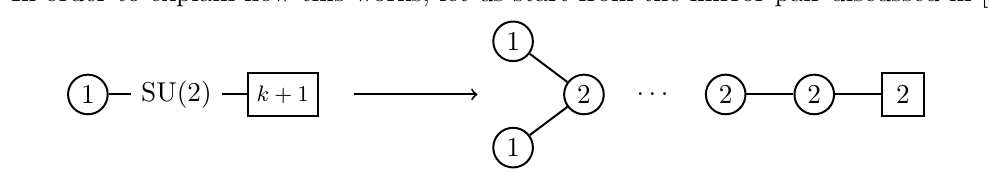
Figure 5. On the left we have a special case of a N = 4 unitary quiver ending with a symplectic gauge group. The theory on the right is the corresponding mirror dual depicted in (cid:12)gure 61 of [26]. The number of U(2) gauge groups on the right is k (cid:0) 1.